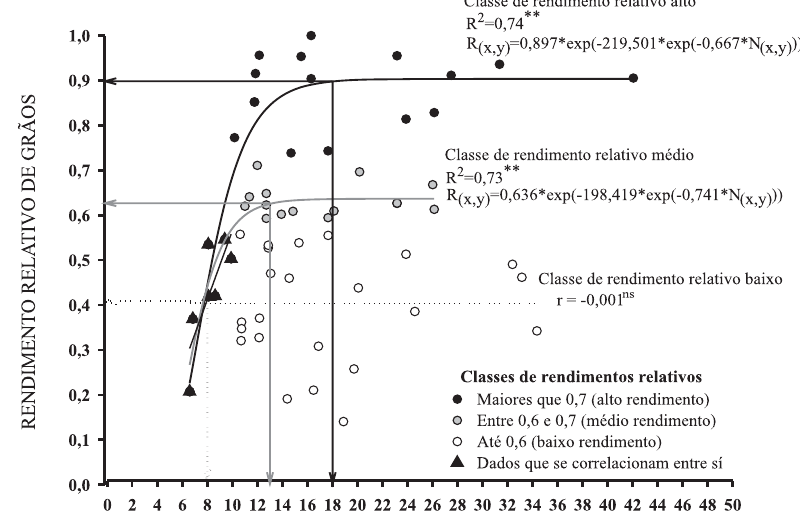
Figura 5. Modelo de Gompertz ajustado para os dados em cada classe de rendimento relativo. Os dados correlacionados até 10 mg kg -1 de N no solo ( ) foram considerados a origem dos modelos. As setas indicam os marcos delimitadores de N mineral, que definem o ponto inicial de estabilidade das curvas dos